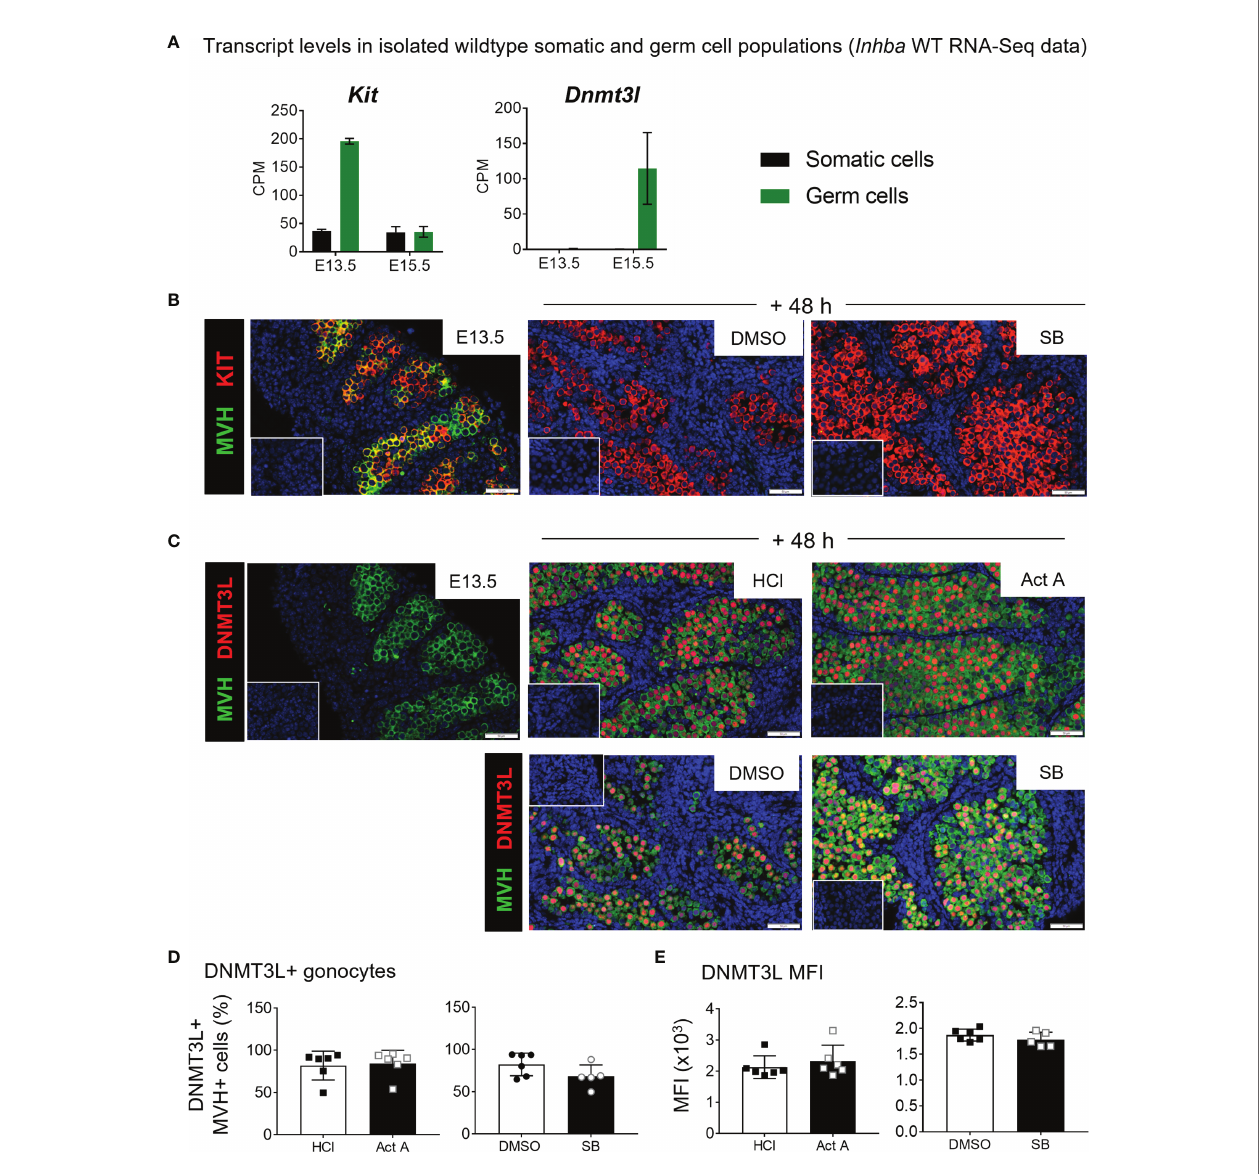
FIGURE 7 | KIT and DNMT3L expression in E13.5 testis cultures. (A) E13.5 and E15.5 transcript levels of Kit and Dnmt3l from FACS-sorted Inhba WT somatic and germ cell RNA-Seq data, expressed in counts per million (CPM). (B, C) Immuno fl uorescence staining of E13.5 and cultured testes. (B) Detection of KIT (red) and MVH (green) marking germ cell cytoplasm in E13.5 testis and E13.5 testes cultured for 48 hours with 10 µM SB431542 or DMSO control. (C) Detection of DNMT3L (red) and MVH (green) in E13.5 testis and those cultured 48 hours with 50 ng/mL activin A or 10 µM SB431542 and respective vehicle controls. DAPI staining in blue marks nuclei. Scale bars are 50 µm, insets represent controls lacking primary antibody. (D, E) Flow cytometry measuring (D) proportion of DNMT3L-positive MVH- positive germ cells and (E) mean fl uorescent intensity (MFI) of DNMT3L-positive population following 48 hr culture with activin A or SB431542. All graphical data are presented as mean ± SD and signi fi cant differences determined by a Student ’ s t-test or Mann-Whitney test following the Shapiro-Wilk or D ’ Agostino and Pearson normality